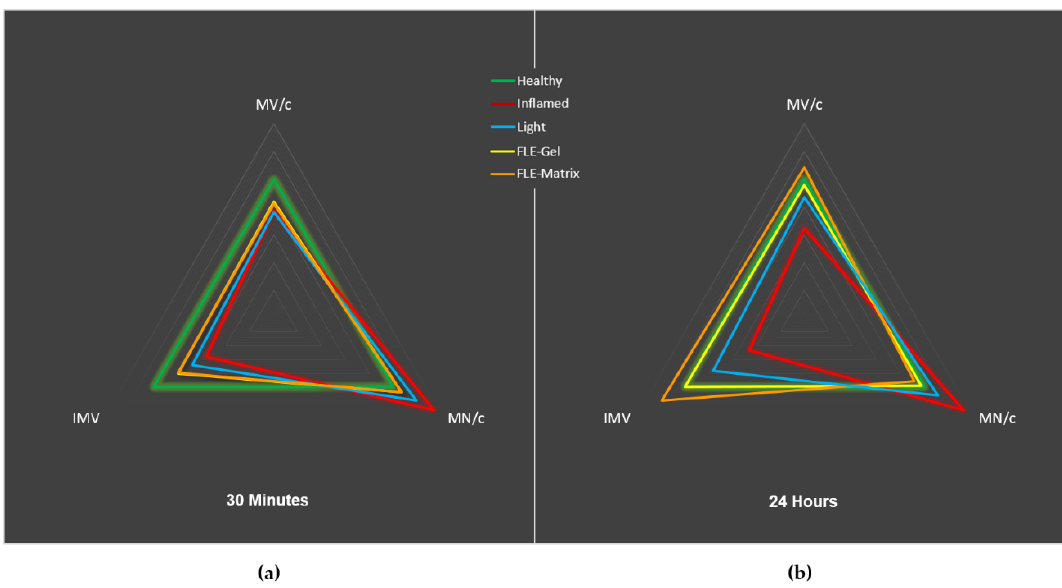
Figure 3. Radial graphs depicting relative changes in mitochondrial networks at ( a ) 30-min and ( b ) 24-h post-treatment. All parameters are indexed to Healthy-HDFs (green). Inflamed-HDFs are depicted in red, Light-treated HDFs in blue, FLE-Gel in yellow, and FLE-Matrix in orange. At time point 30-min the FLE-Gel (yellow) and FLE-Matrix (Orange) overlap, and at time point 24-h the Healthy (green) and FLE-Gel (yellow) overlap. MV / c = Mitochondria Volume per cell ; MN / c = Mitochondria Number per cell ; IMV = Individual Mitochondrion Volume.